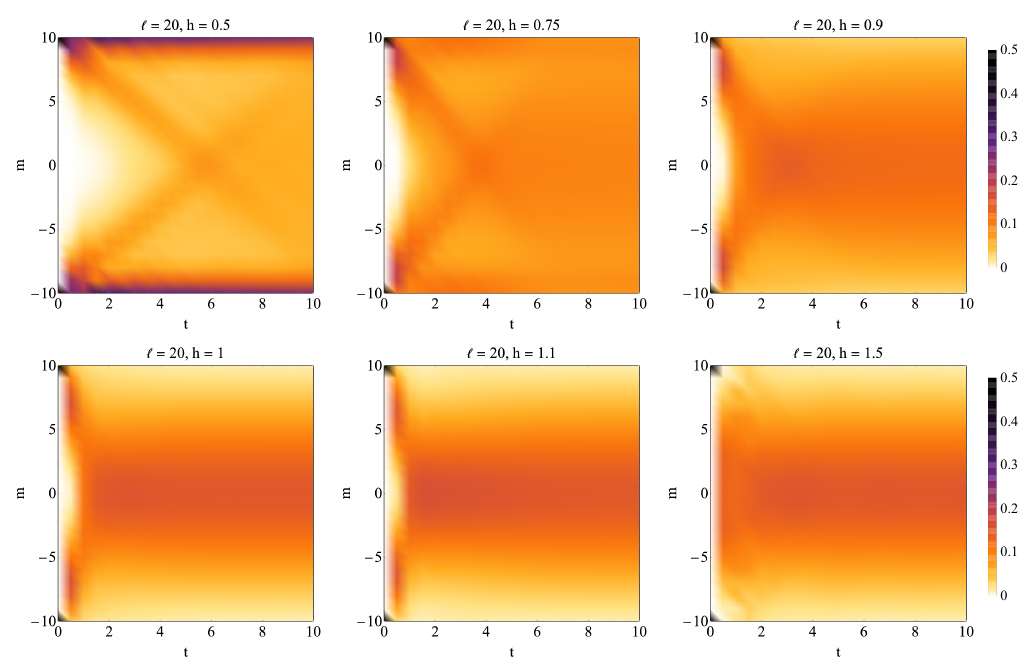
Figure 1: Color density plot of the time evolution of the PDF of the subsystem or- der parameter for subsystem sizes (cid:96) = 20 and different values of the post-quench transverse field h